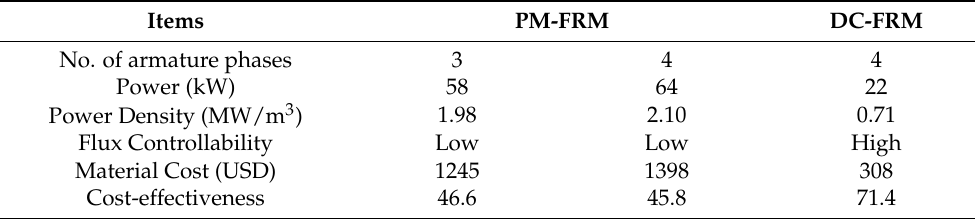
Table 1. PM-FRM vs. DC-FRM (adapted from [24] with costs from 2015). Items PM-FRM